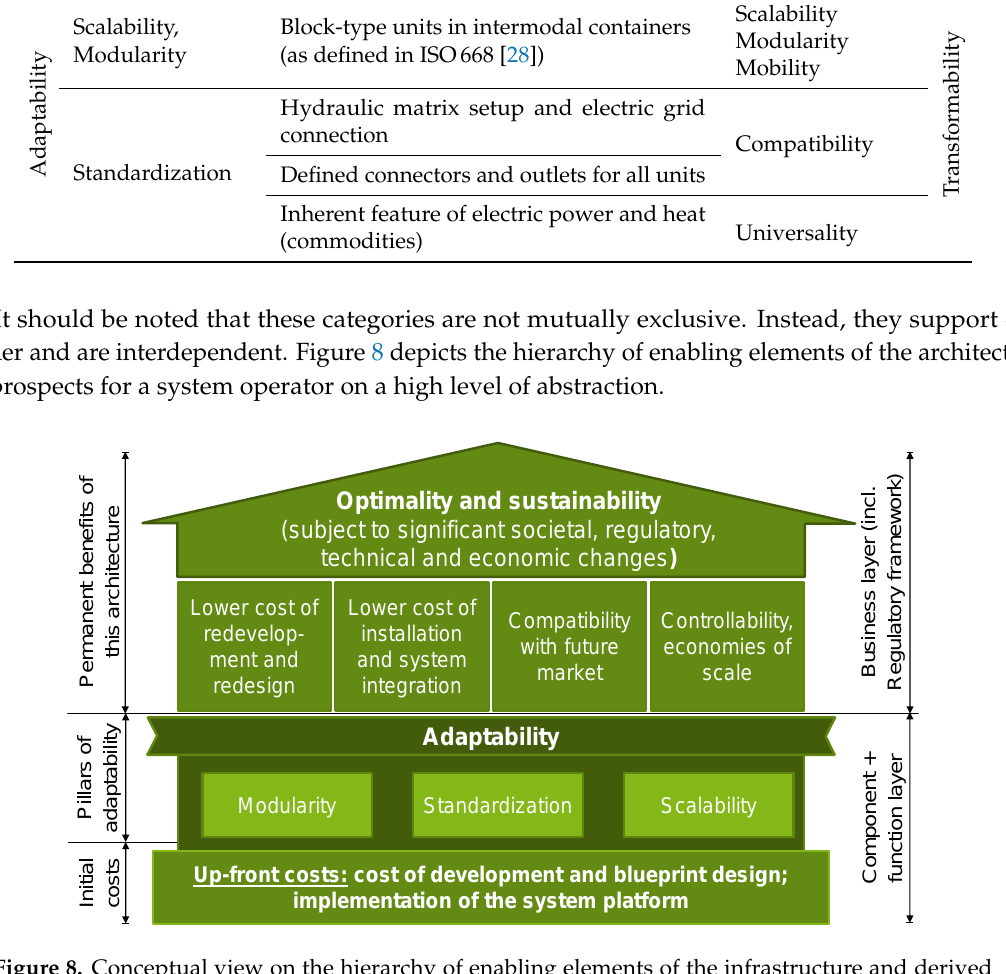
Figure 8. Conceptual view on the hierarchy of enabling elements of the infrastructure and derived benefits of an